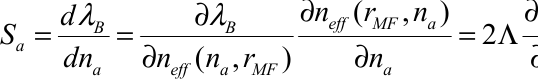
in the range 0.5–5 μ m. MF